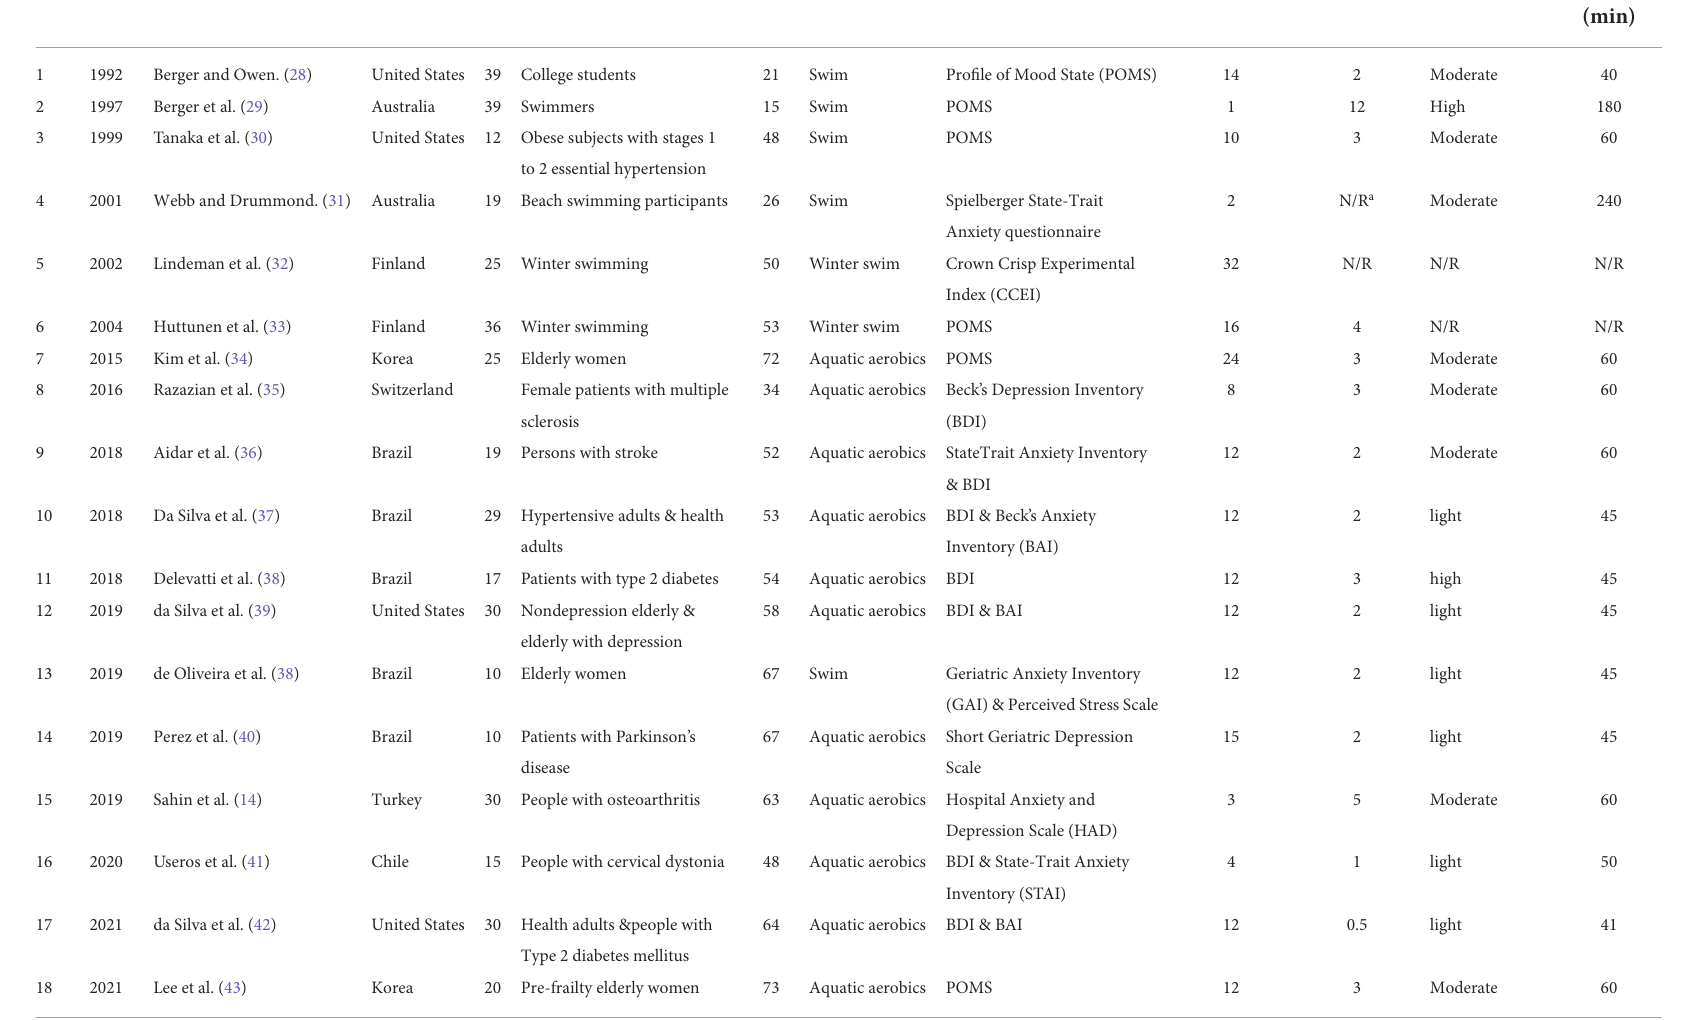
TABLE 2 General